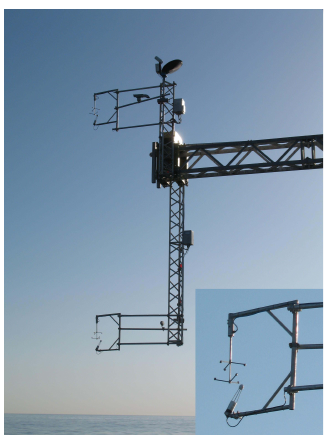
Figure 2. Instrument boom at FINO2 with the turbulence sensors at both heights and instrument installation in more detail